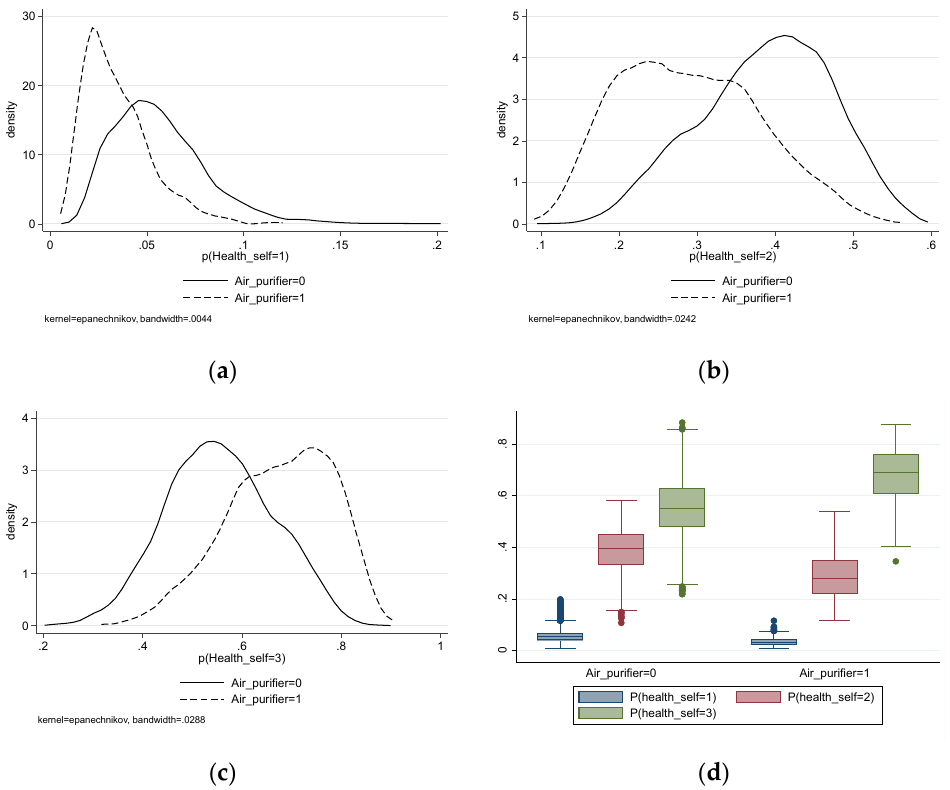
Figure 1. The plots for the predicted probability of self ‐ rated health level: ( a ) kernel density plot of predicted probability for health_self = 1; ( b ) kernel density plot of predicted probability for health_self = 2; ( c ) kernel density plot of predicted probability for health_self = 3; ( d ) boxplot of predicted probabilities for health_self. Table 3. Regression results of the effect of indoor air purification on residents’ self ‐ rated health based on the generalized ordinal logit model.